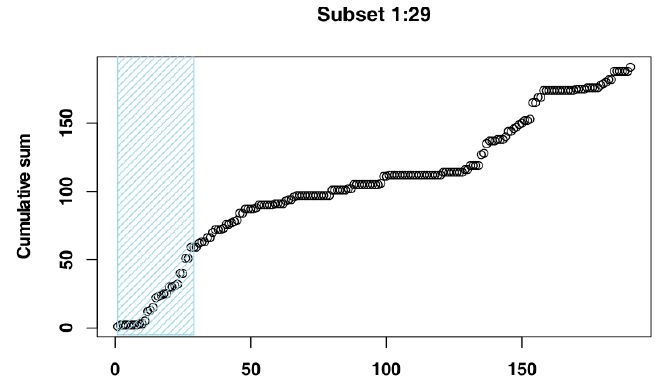
Figure 3. Selected subset for Czech Republic data.